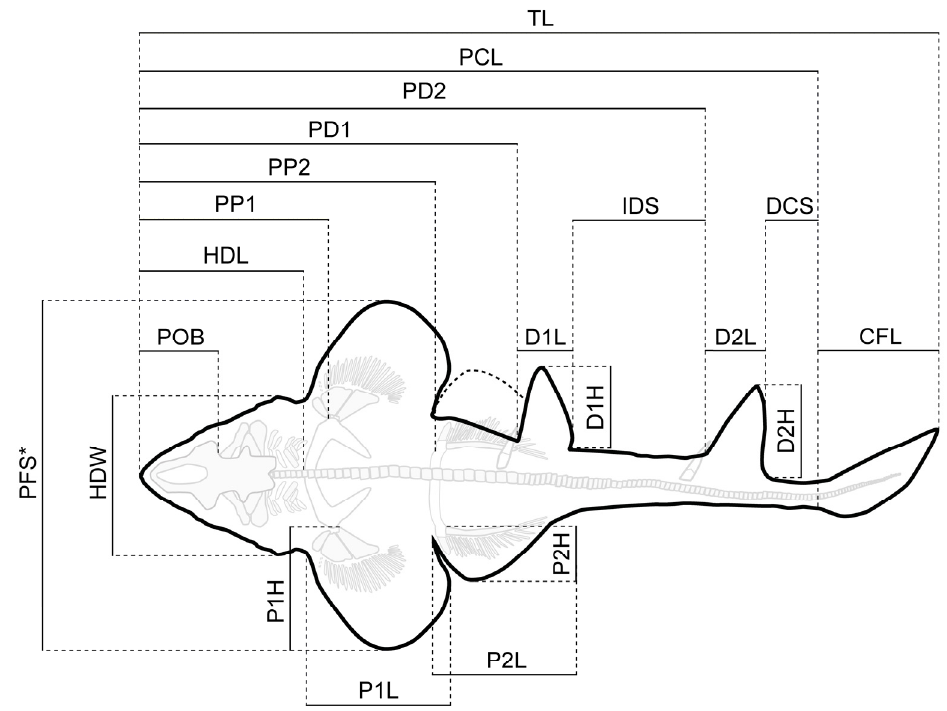
Figure 2. Simplified outline drawing of Protospinax annectans Woodward, 1918 from the lower Tithonian Solnhofen Archipelago showing the measurements listed in Table 1. Abbreviations : CFL , caudal fin length; D1H , first dorsal height; D2H , second dorsal height; D1L , first dorsal length; D2L , second dorsal length; DCS , dorsal caudal space; HDL , head length; HDW , head width; IDS , interdorsal space; P1H , pectoral height; P2H , pelvic height; P1L , pectoral inner margin length; P2L , pelvic inner margin length; PCL , precaudal length; PD1 , pre-first dorsal length; PD2 , pre-second dorsal length; PFS , pectoral fin span; POB , preorbital length; PP1 , prepectoral length; PP2 , prepelvic length; TL , total length. *The pectoral fin of the right side was partly missing and PFS was estimated by measuring the distance between the tip of the pectoral fin and the vertebral column (perpendicular to the axial axis) and then multiplying this distance by two. Table 1. Morphometric data for three well-preserved specimens (PBP-SOL-8007, MB 14-12-22-1, UMN uncatalogued) and the holotype (NHMUK PV P 8775) of Protospinax annectans Woodward, 1918 from the lower Tithonian of the Solnhofen Archipelago, Bavaria, Germany. Measurements followed Compagno [72] and are summarized in Figure 2. Abbreviations : CFL , caudal fin length; D1H , first dorsal height; D2H , second dorsal height; D1L , first dorsal length; D2L , second dorsal length; DCS , dorsal caudal space; HDL , head length; HDW , head width; IDS , interdorsal space; P1H , pectoral height; P2H , pelvic height; P1L , pectoral inner margin length; P2L , pelvic inner margin length; PCL , precaudal length; PD1 , pre-first dorsal length; PD2 , pre-second dorsal length; PFS , pectoral fin span; POB , preorbital length; PP1 , prepectoral length; PP2 , prepelvic length; TL , total length. PBP-SOL-8007